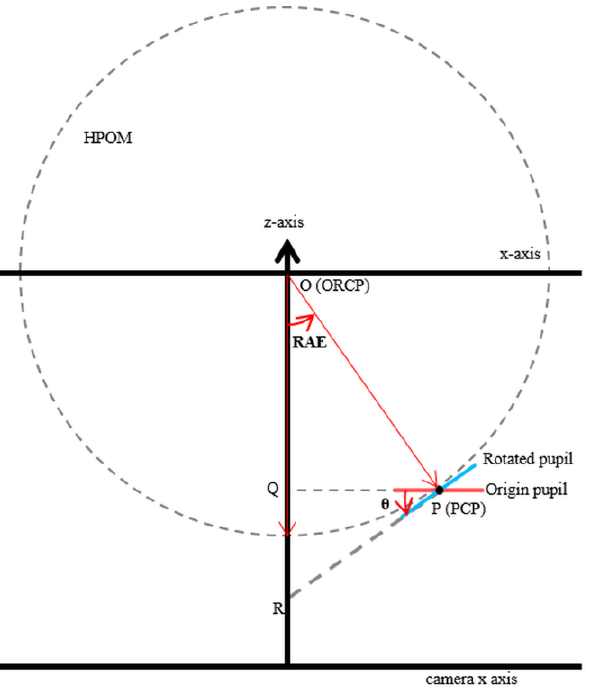
Figure 6. Relationship between the RAE of HPOM and the rotation angle of the